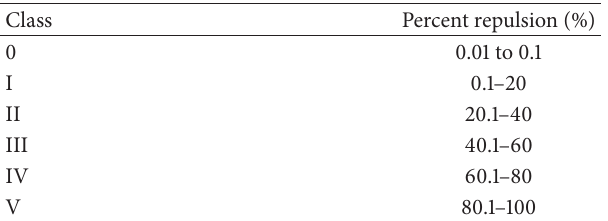
Table 2: GC-MS analysis of essential oil of Ageratum houstonianum aerial